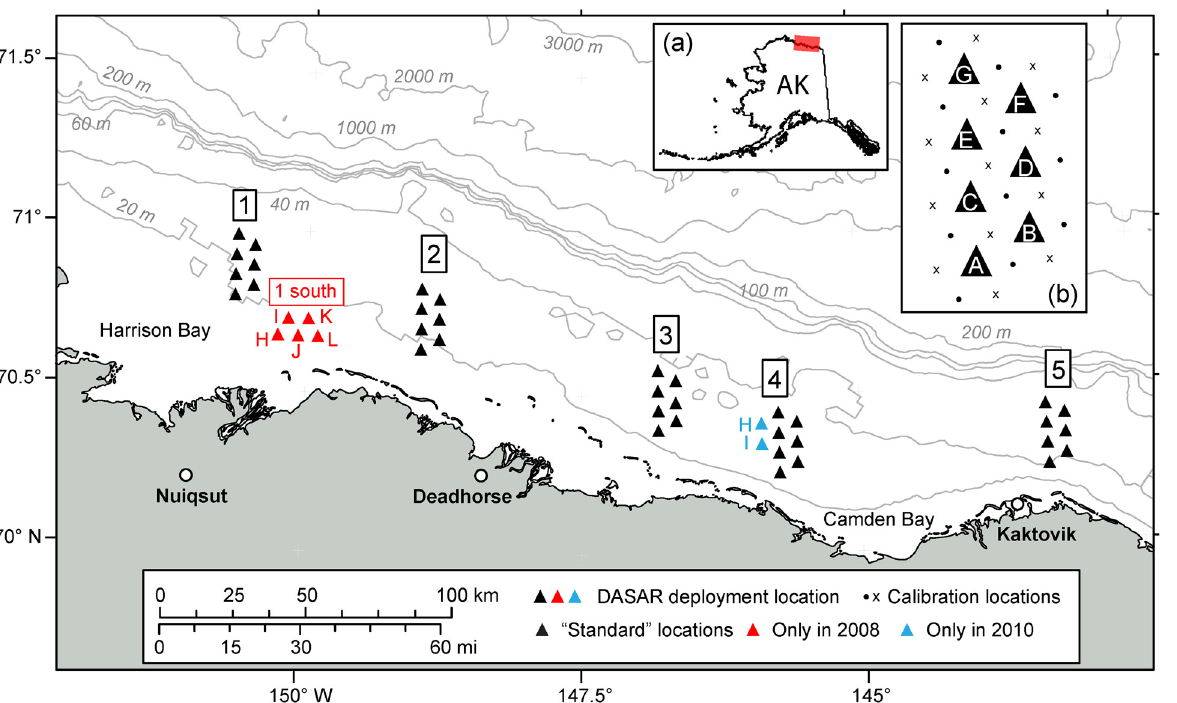
Fig 1. DASAR deployment locations used in the 2007 – 2010 field seasons. Inset (a) shows the location of the arrays on the map of Alaska. The five main, seven-DASAR arrays (black triangles), labeled 1 – 5 from west to east, were deployed each year, conditions permitting (ice prevented some deployments in 2010, see Table 1). DASARs were labeled A – G from south to north, as shown in inset (b). Other locations were used only in some years. In 2008 five recorders were deployed south of site 1: DASAR locations 1H, 1I, 1J, 1K, and 1L (red triangles). In 2010 two recorders were deployed west of site 4: DASAR locations 4H and 4I (blue triangles). Inset (b) shows calibration locations with respect to the DASARs ’ locations at a single array. The same relative calibration locations were used at each